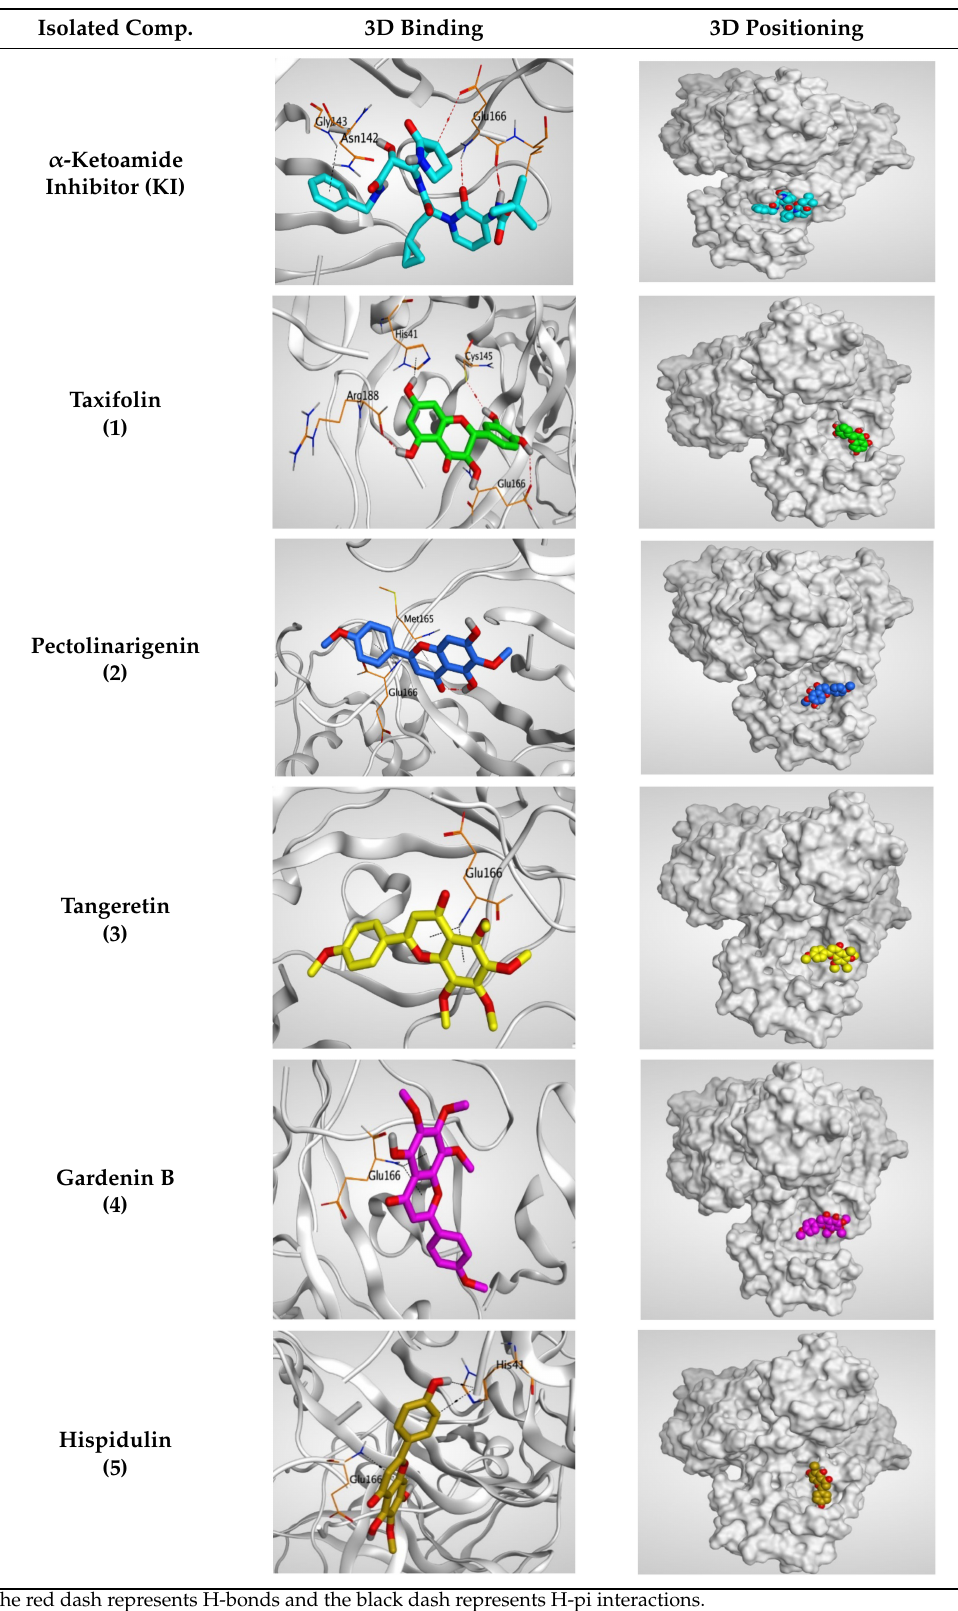
Table 2. 3D pictures showing the receptor interactions and positioning between the docked KI in addition to the five examined flavonoids ( 1 – 5 ) inside the binding site of SARS-CoV-2 Mpro. Isolated Comp.